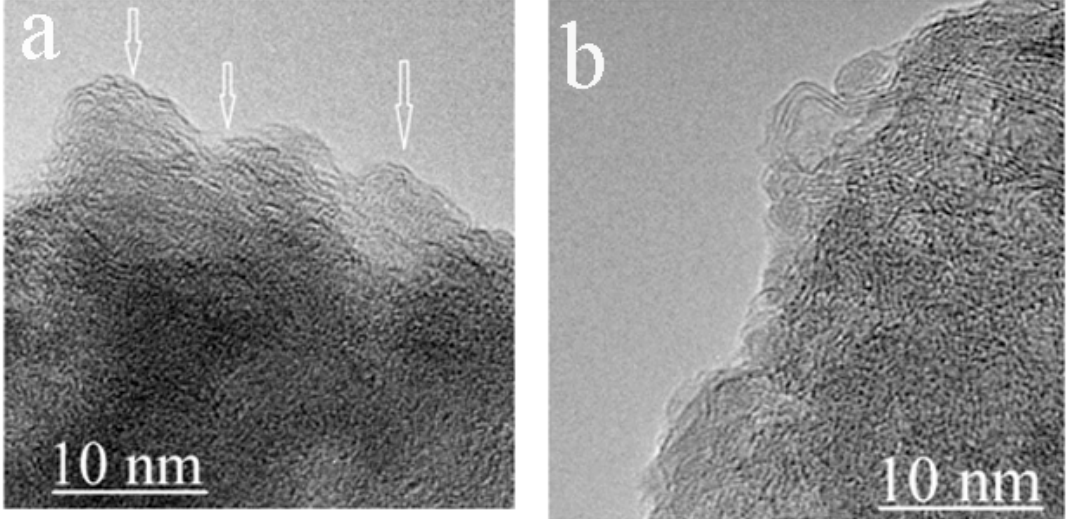
Figure 3. TEM images of the g -C 3 N 4 specimen after shear deformation at 20–25 GPa; ( a ) an image with graphene-like layers shown by arrows. ( b ) An image showing an onion-like structure of atypical size.